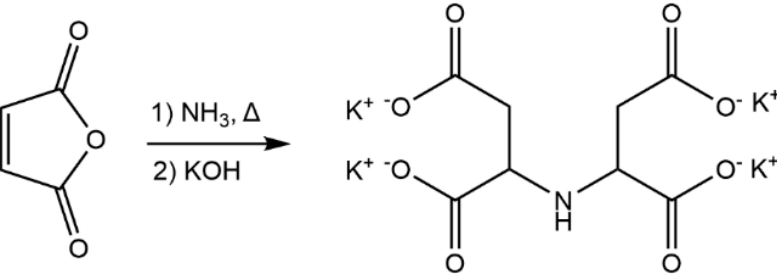
Figure 1. Reaction scheme for the synthesis of IDSK salt from maleic anhydride and ammonia.